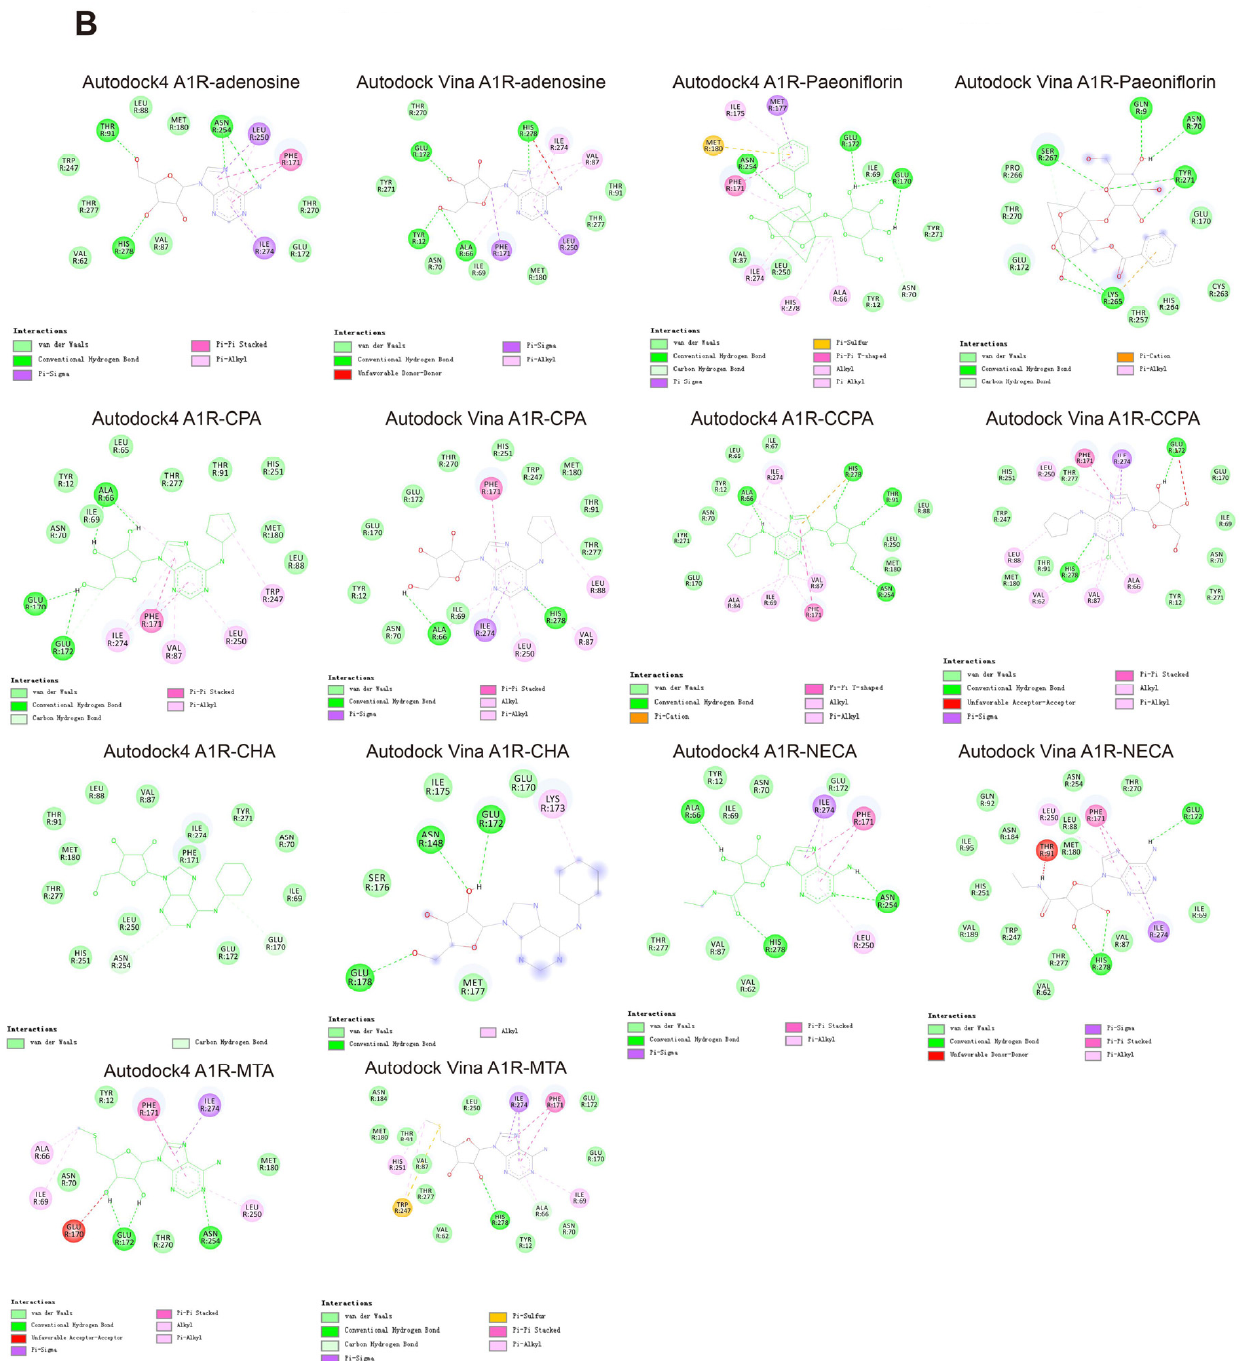
Figure 5. Molecular docking analyses between A1R and its agonists. ( A ) The output of AutoDock4 and AutoDock Vina showed the binding site residues of A1R with the ligand TSG edited in PyMOL/Discovery Studio 4.5 software. TSG (yellow stick format) was docked in the lowest energy conformation inside the binding pocket of A1R (shown in marine and violet). Detailed binding site residues (green color) of A1R protein with the ligand TSG (green stick format) and 2D diagram showed the types of contacts formed between A1R and TSG. The green dotted lines indicated H-bond interactions between A1R and TSG. ( B ) Two-dimensional diagrams showing the types of contacts formed between A1R and its known agonists (adenosine, paeoniflorin, CPA, CCPA, CHA, NECA and MTA) output by AutoDock4 and AutoDock